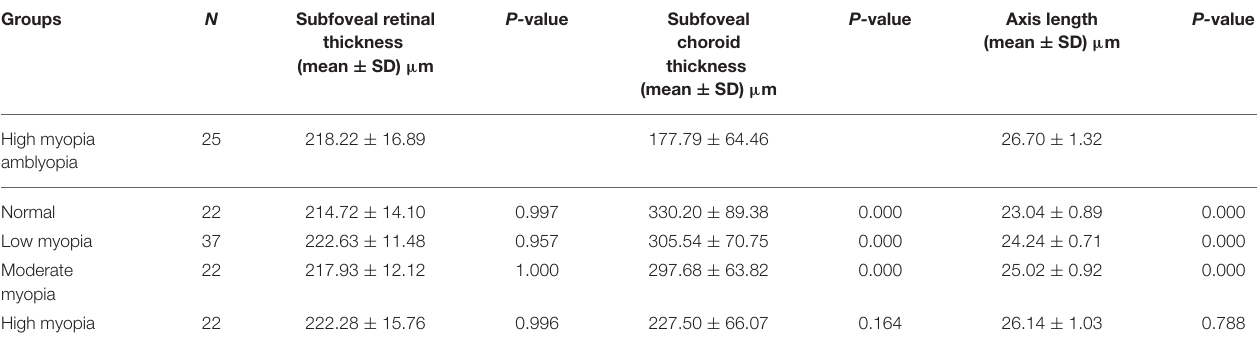
TABLE 2 | Subfoveal retinal and choroidal thickness, axial length in all five groups. Groups